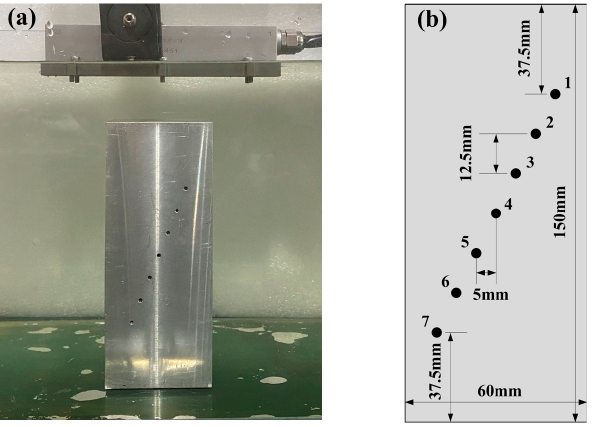
Figure 4. The array probe and sample for the experiment: ( a ) the probe and sample; ( b ) the defect of the sample